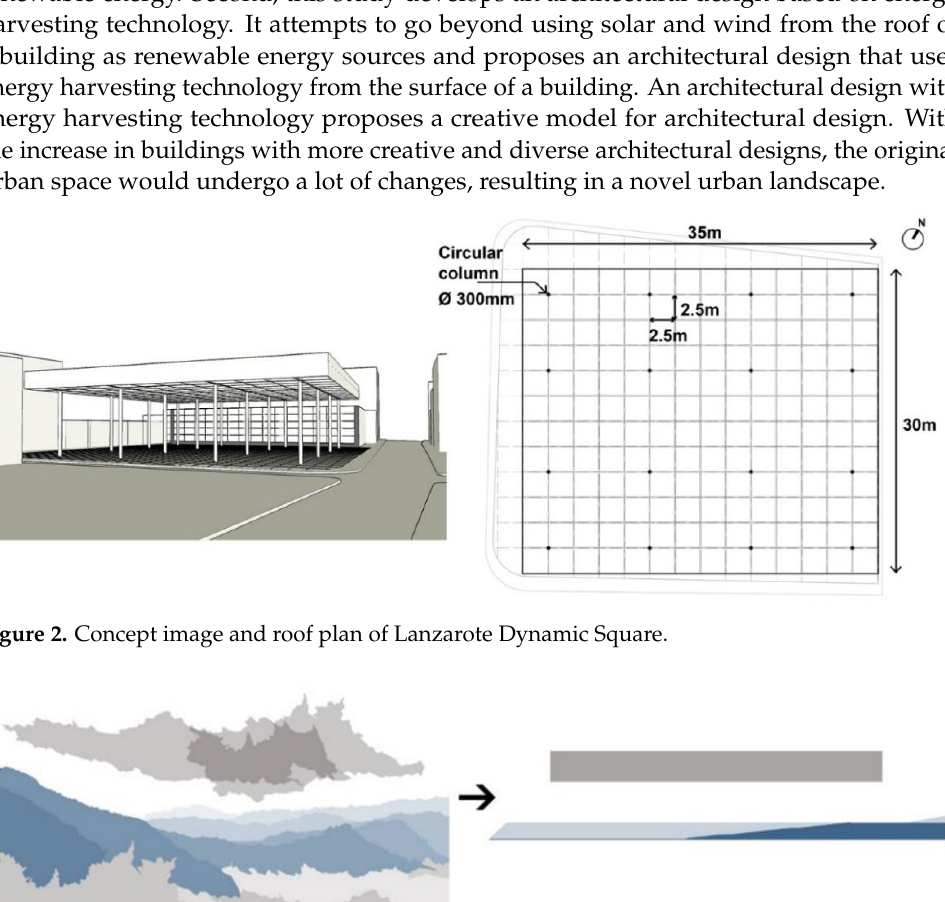
Figure 3. Square roof design, which symbolizes the clouds around Lanzarote Island.